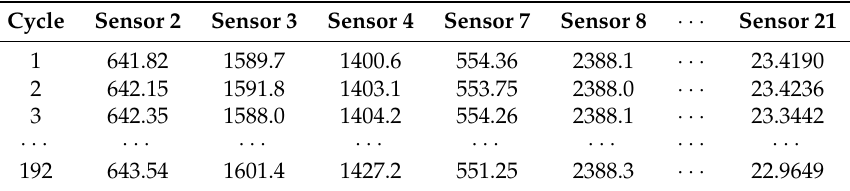
Table 3. Sensor data set for evaluation